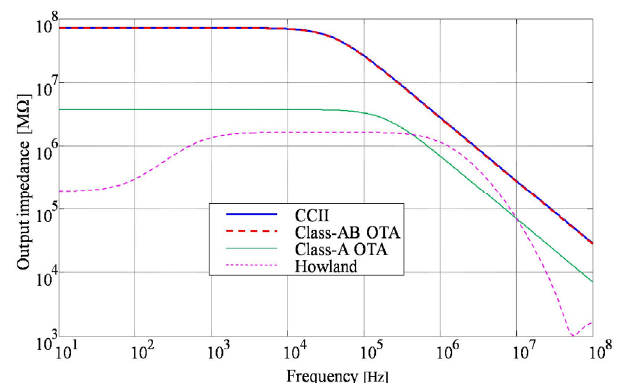
Fig.8: Output impedance over the frequency range 10 Hz to 100